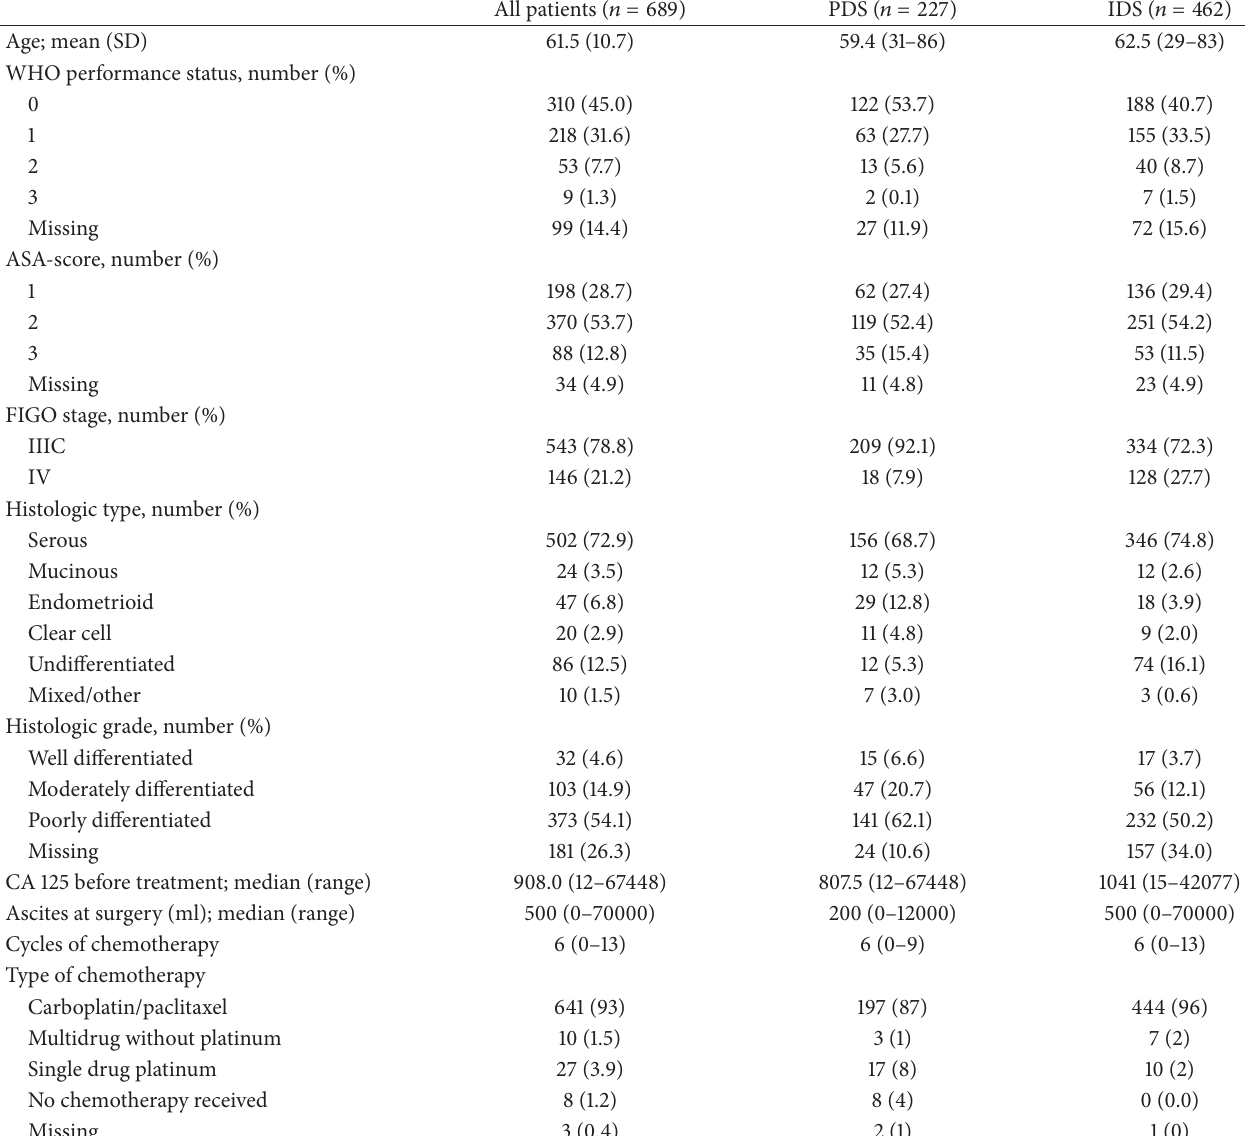
Table 1: Baseline characteristics.